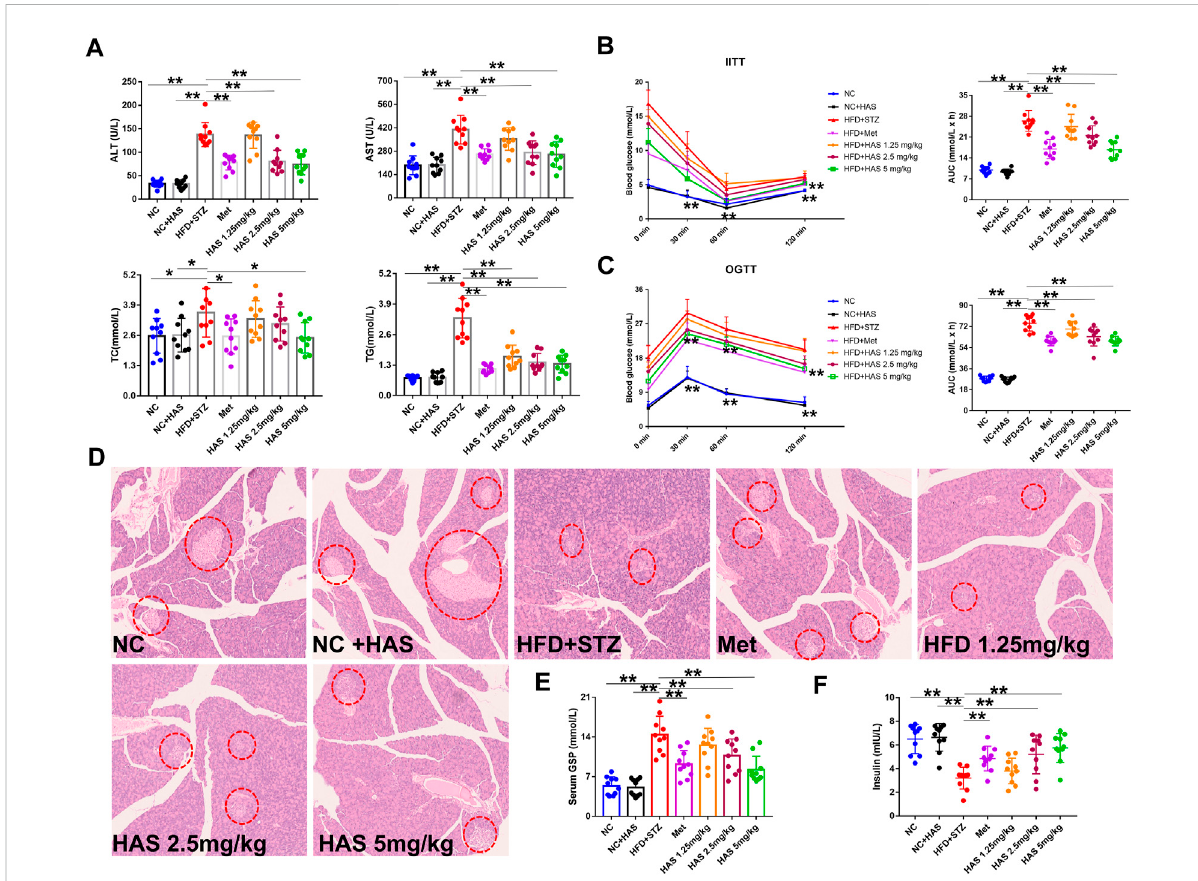
FIGURE 2 EffectsofHASonserum biochemistryandinsulinresistanceinT2DM mice. (A) EffectsofHASonALT,AST,TC,andTGinT2DM mice. (B) Effects of HAS on ITT in T2DM mice. (C) Effects of HAS on OGTT in T2DM mice. (D) Effects of HAS on histopathology of the pancreas of T2DM mice; islet B cells in pancreatic tissue are marked with red circles. (E,F) Effects of HAS on GSP and insulin content in T2DM mice. The doses of 2.5, 5.0, and 10 mg/kg indicate low, middle, and high doses of HAS, respectively, and the dose ofMet was 150 mg/kg. Data are expressedas mean ± SD ( n = 10), ** p < 0.01 vs. HFD + STZ